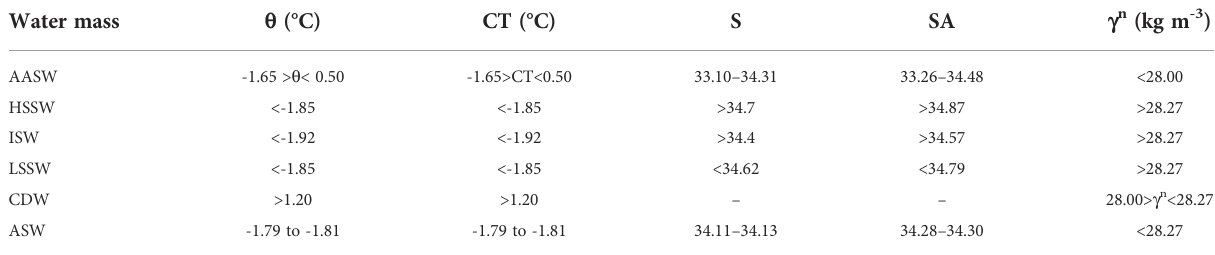
TABLE 1 Bounding potential temperature ( q ), salinity and neutral density ( g n ) values that de fi ne the major water masses in the area investigated by the ESTRO cruise. Water mass